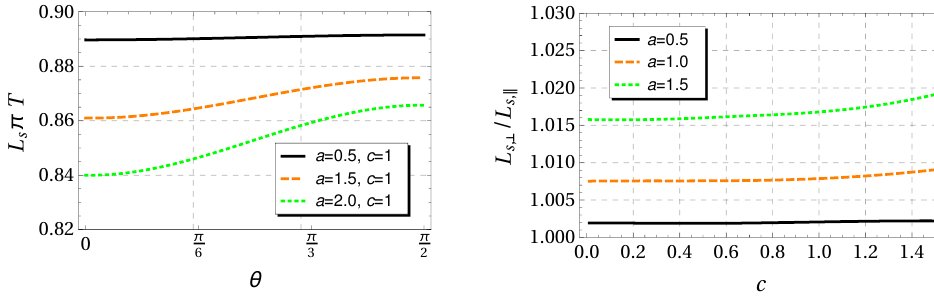
Figure 9 . The screening distance as a function of the angle between the anisotropic direction and the q (cid:22) q -pair (left) and the ratio of the screening distance parallel and perpendicular as a function of c (right). The left (cid:12)gure shows that the larger a the large the angle a(cid:11)ects the screening distance. The right (cid:12)gure shows that c only marginally a(cid:11)ects the dependence of L s on the orientation. The numerical results show that the quantitative e(cid:11)ect of the two parameters on